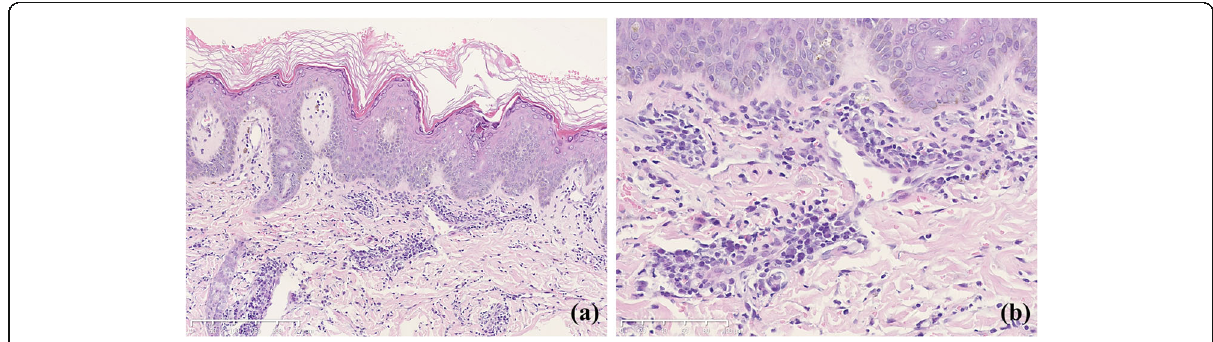
Fig. 2 Biopsy results. H&E staining of erythematous lesions on hands. a Hyperkeratosis, irregular epidermal hyperplasia, mild spongy edema and single necrotic keratinocytes in epidermis along with mild vacuolar degeneration. Scale bars: 250 μ m. b Medium monocytes with neutrophilic cells infiltrated around dermal vessels. Nuclear dust and mitotic figures were seen. Scale bars: 100 μ